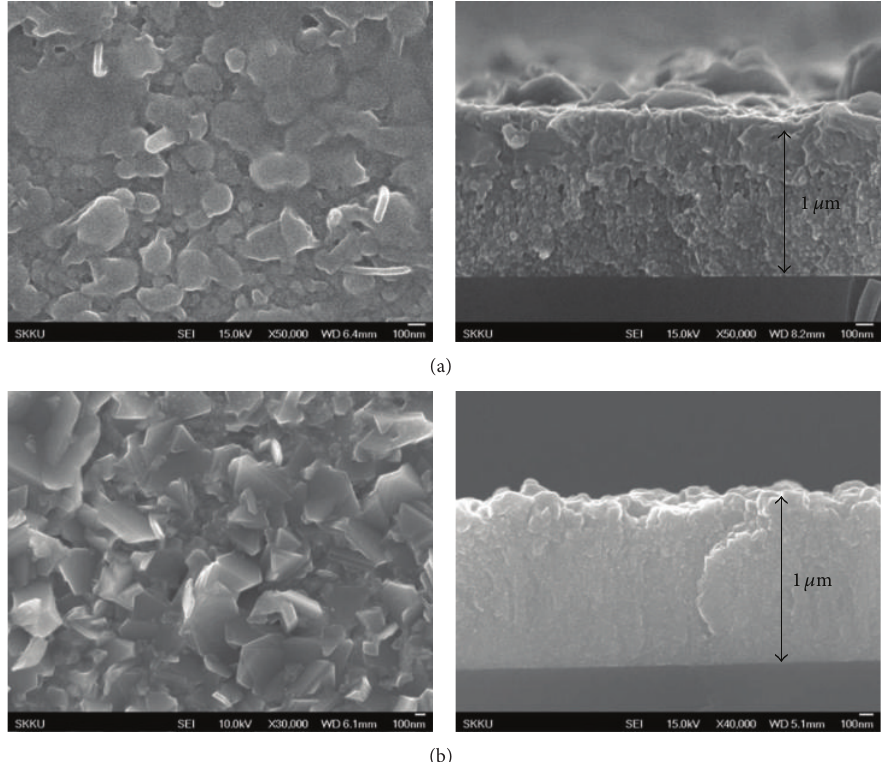
Figure 2: SEM images of CZTS thin films deposited with target powers Cu:SnS: ZnS:15:30 :80W and annealed at 500 ∘ C (a) H 2 S + N 2 gas and (b) sulfur